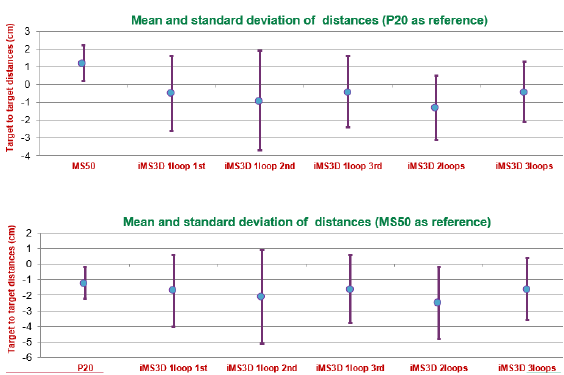
Figure 9. Target to Target evaluation; a) Leica P20 TLS as reference, b) Leica MS50 as reference.